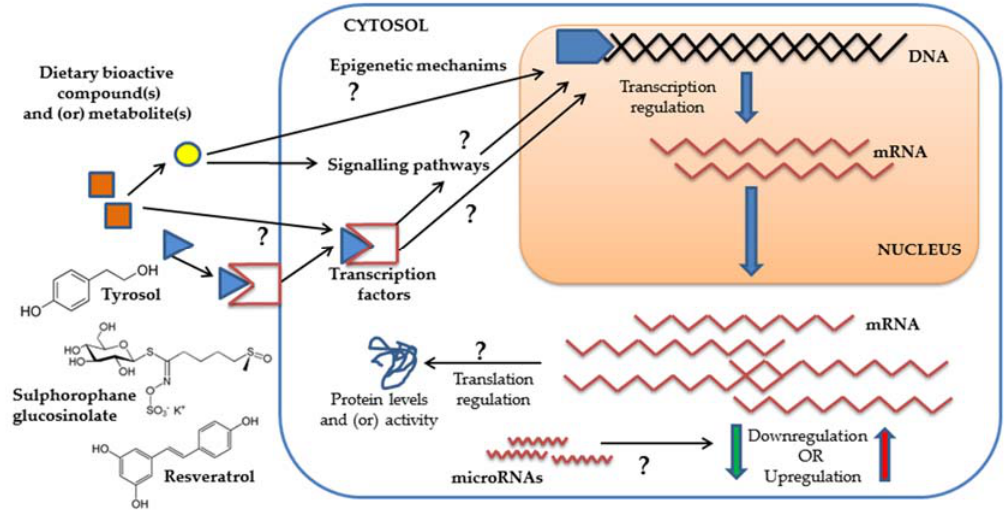
Figure 1. Scheme summarizing some of the general potential molecular mechanisms triggered in cells by bioactive compounds and/or derived metabolites and that may promote gene expression changes.